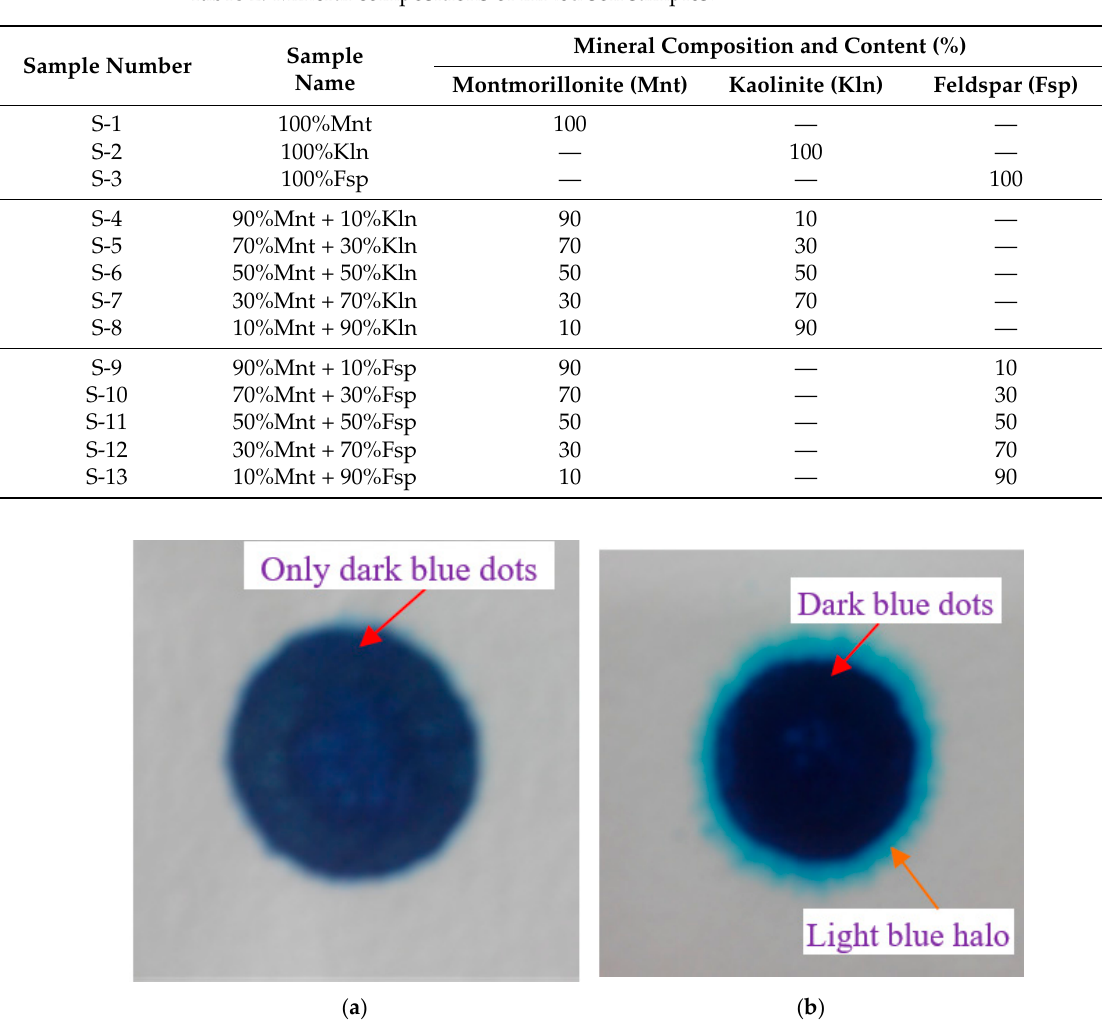
Table 2. Mineral compositions of mixed soil samples.